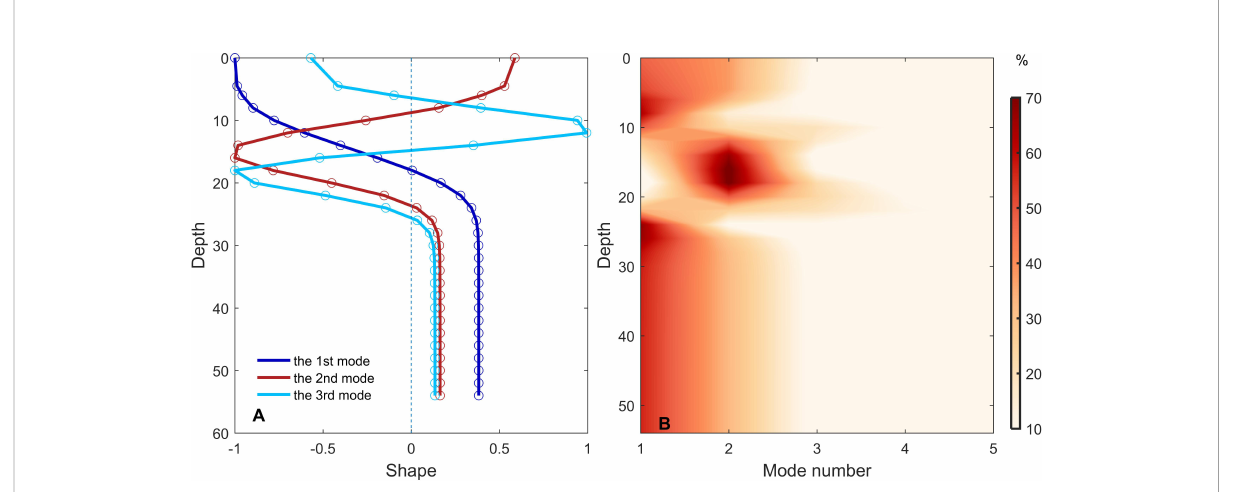
FIGURE 7 (A) Vertical structures of the fi rst three modes of the near-inertial velocity at the mooring site. (B) The percentage of the energy in each mode to the total energy at different